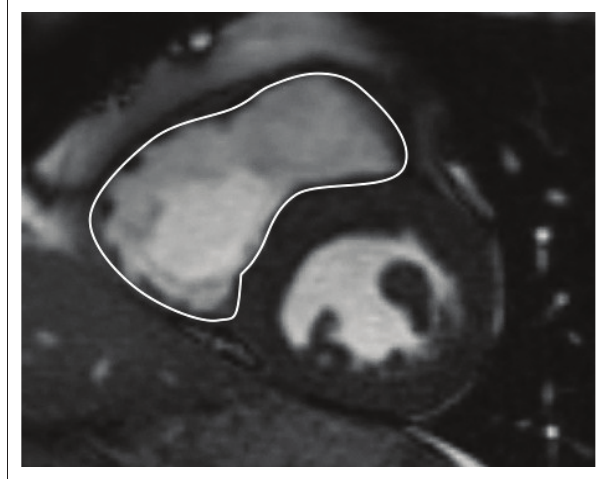
FIGURE 7: Single short-axis cine SSFP image at the mid-ventricular level. The RV is contoured on the stack of short-axis cine images (white line).